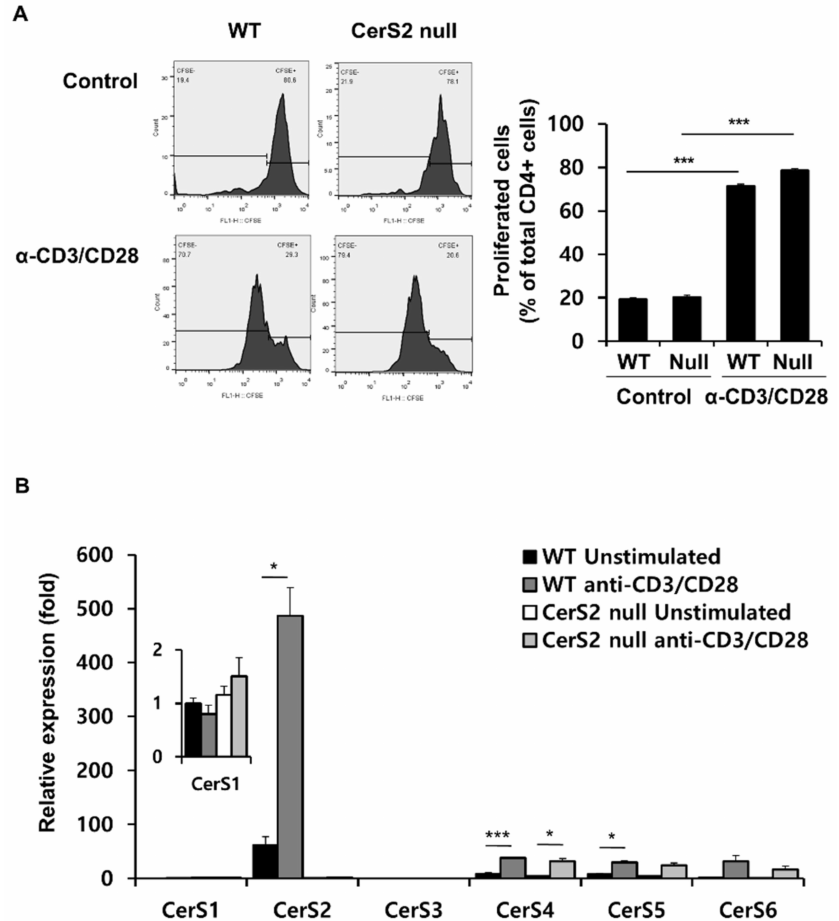
Figure 2. WT-CD4+T and CerS2 null-CD4+T cells show similar proliferation capacities, and CerS2 positively correlates with T cell activation. ( A ) CFSE-labeled CD4+ T cells from wild type and CerS2 null mice were cultured with or without anti-CD3/anti-CD28 antibodies ( α -CD3/CD28) for 5 days, and the degree of proliferation was measured using flow cytometry (left). The percentages of proliferating cells was analyzed (right). Data are expressed as means ± SEM (*** p < 0.001). ( B ) The mRNA expression of CerS1-6 in T cells cultured with or without anti-CD3/anti-CD28 antibodies for 3 days was confirmed by quantitative real-time PCR. Data are expressed as the mean ± SEM ( n = 4). * p < 0.05; *** p < 0.001. Null indicates CerS2 null mice. Statistical significance was analyzed using the two-way analysis of